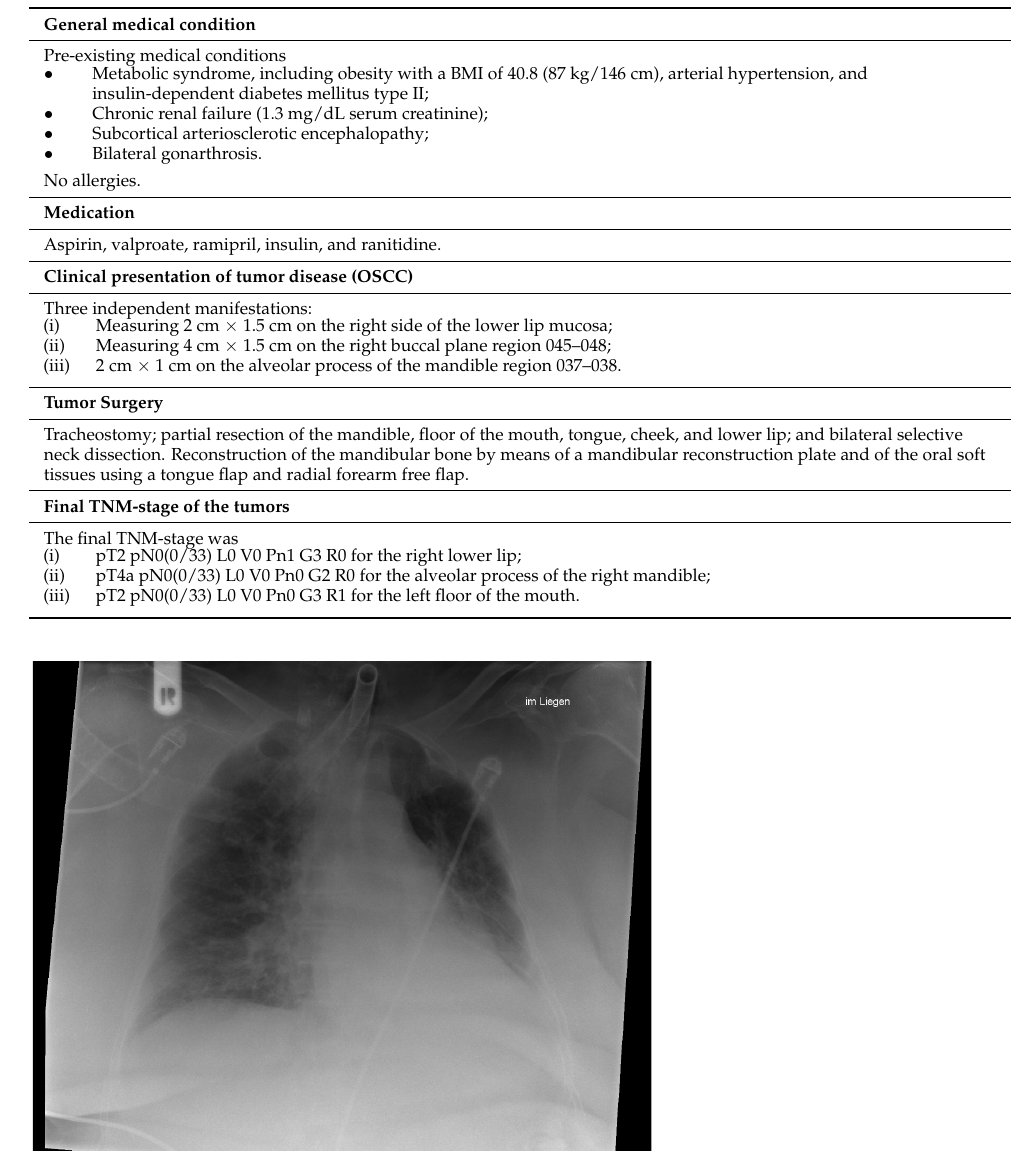
Table 1. Patient and Tumor Characteristics.